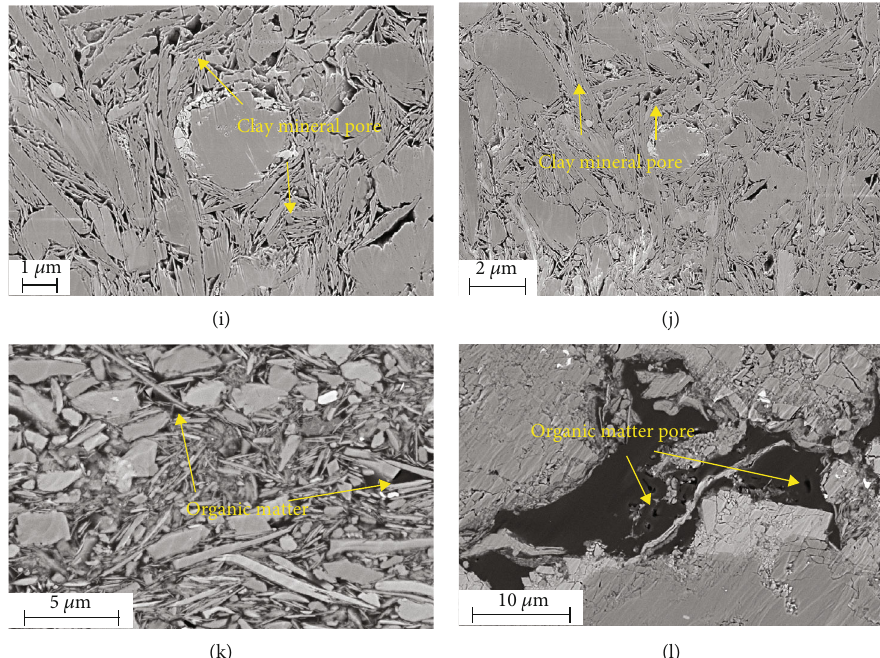
Figure 3: SEM photographs of di ff erent types of pores in mudstone samples of the Qigequan Formation (by backscattered electron). (a) Tn- 18: pure mudstone and the overall morphology characteristics of minerals and pores. (b) Tn-18: pure mudstone, micron organic matter, and organic matter pore. (c) Tn-18: silty mudstone and nanoorganic matter. (d) Tn-18: silty mudstone and nanoclay mineral pore. (e) Tn-18: silty mudstone and micron intergranular pore. (f) Tn-18: sandy mudstone and micro-nanointragranular pore. (g) Tn-18: sandy mudstone and intergranular pore. (h) Tn-18: sandy mudstone and intragranular pore. (i) Tn-18: pure mudstone and clay mineral pore. (j) Tn-18: pure mudstone and clay mineral pore. (k) St-1: pure mudstone and organic matter. (l) St-1: silty mudstone and organic matter